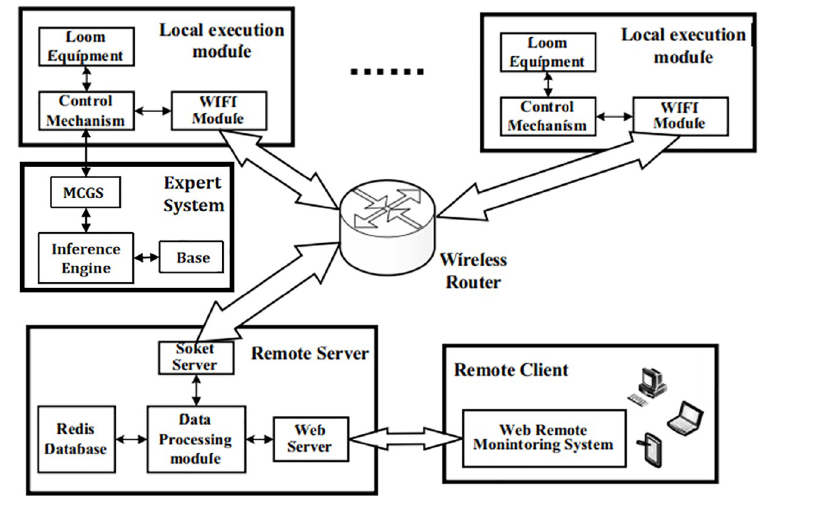
Fig 5. Overall framework of HCI